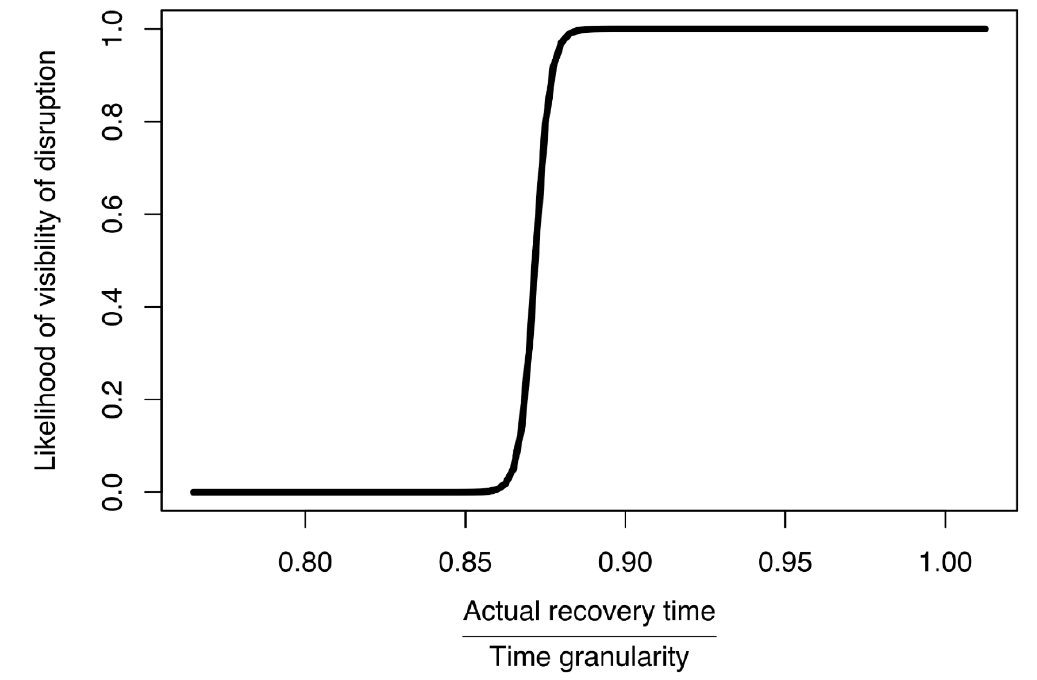
Figure 8. Model of likelihood for disruption visibility based on ratio of actual recovery time to time granu- larity (RT/TG).